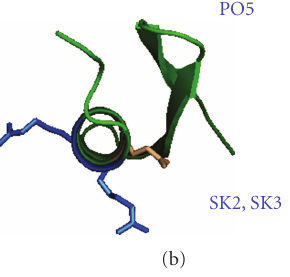
the interaction between P05 and SK channels at the level of the molecular